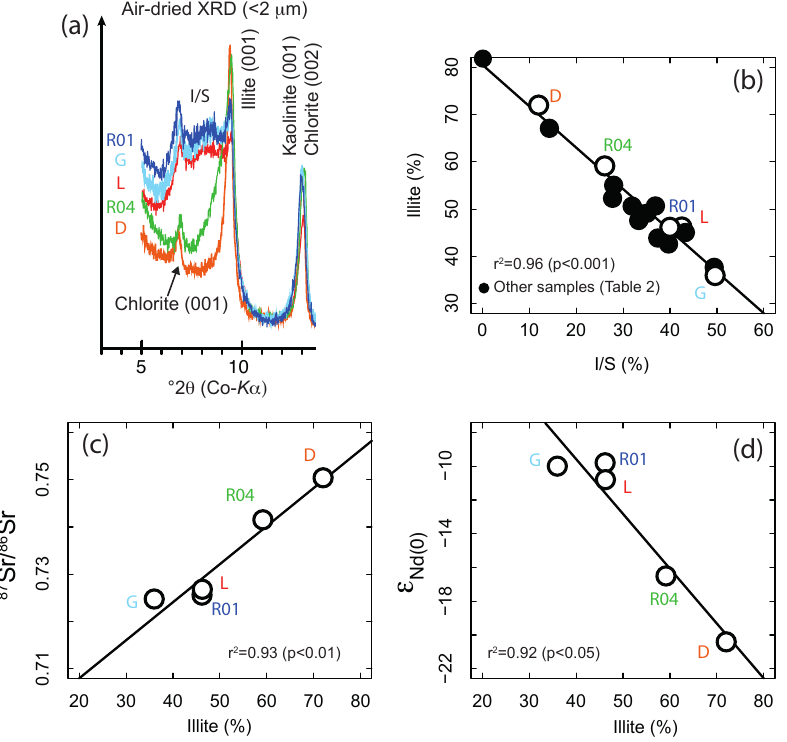
Figure 7. (a) Part of the orientated clay XRD spectrum (air-dried) for five samples. I/S stands for a mixed layer clay containing smectite and illite. Note the decrease in the I/S peak from R01 to D. (b) The relative abundances of illite and I/S in the clay fraction are inversely correlated. (c, d) There is a positive correlation between the relative abundance of illite and the radiogenic strontium isotope ratio in the clay fraction and an inverse correlation with the radiogenic neodymium isotope